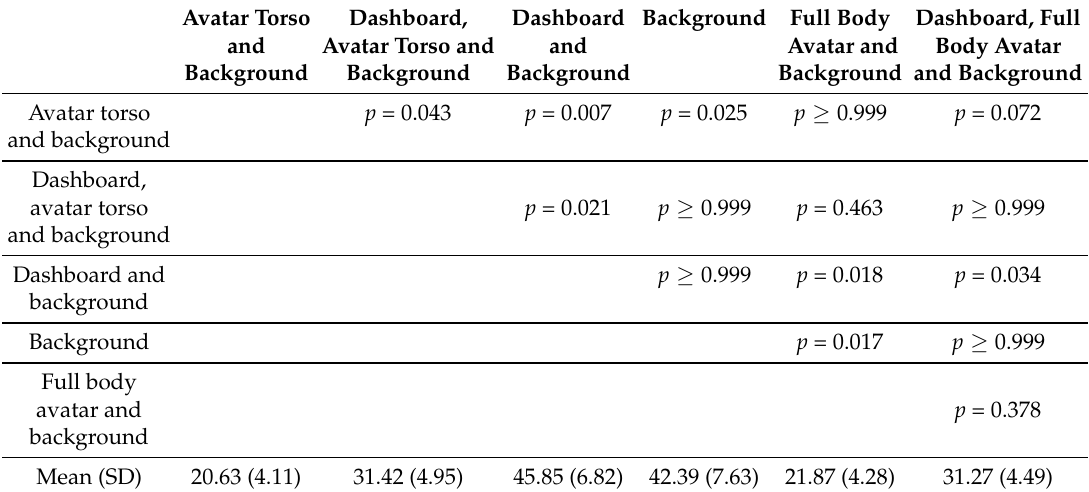
Table 1. Post hoc statistics and descriptive information between all experimental